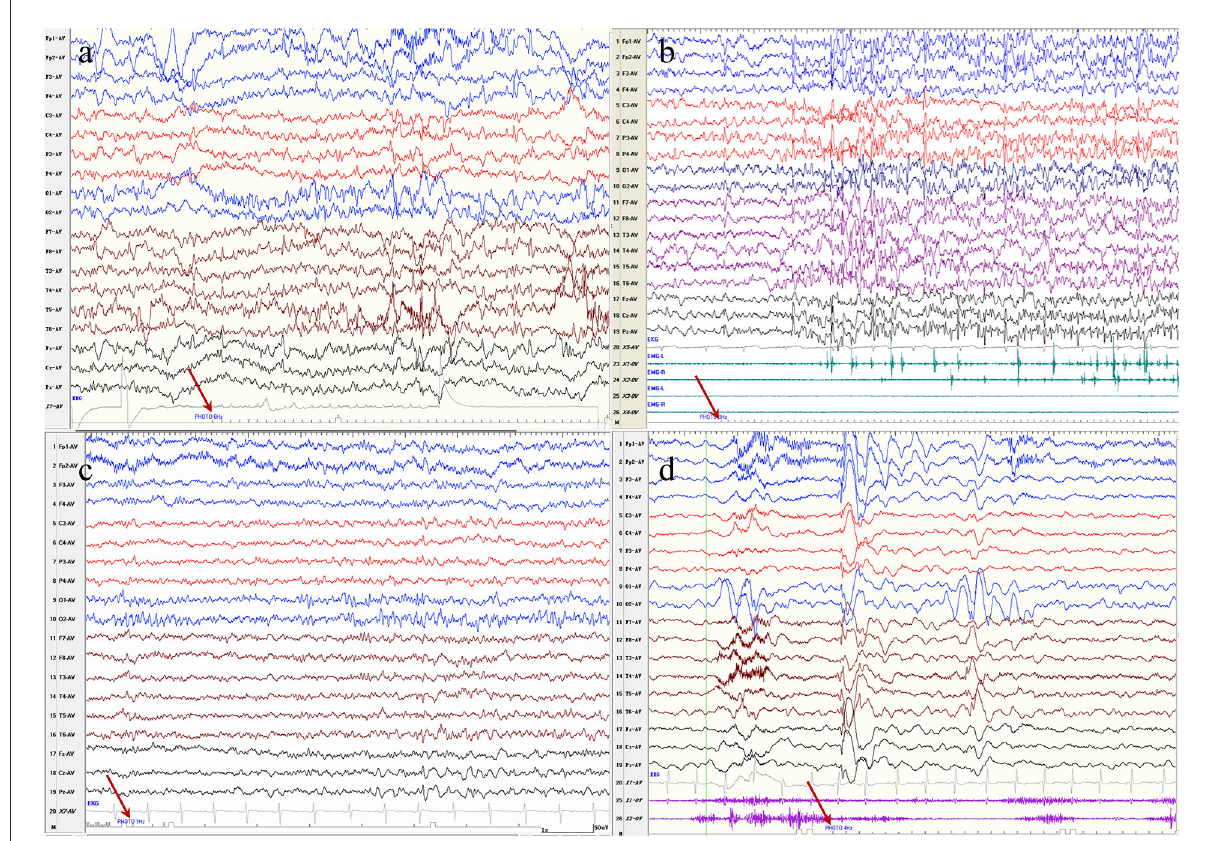
FIGURE2 (a) Electroencephalography of a patient with progressive myoclonus epilepsy with a KCTD7 variant demonstrates bioccipital spike-waves discharges in response to photic stimlation at 6Hz. (b) Electroencephalography of a patient with progressive myoclonus epilepsy with a GBA variant demonstrates generalized spike-waves with a myoclouns seziure in response to photic stimlation at 8Hz. (c) Electroencephalography of a patient with a Lennox-Gastaut syndrome with a CHD2 variant demonstrates a bioccipital spike waves discharges in response to photic stimlation at 1Hz. (d) Electroencephalography of a patient with Jeavons syndrome with a SYNGAP1 variant demonstrates generalized spike waves or posterior discharges in response to photic stimlation at